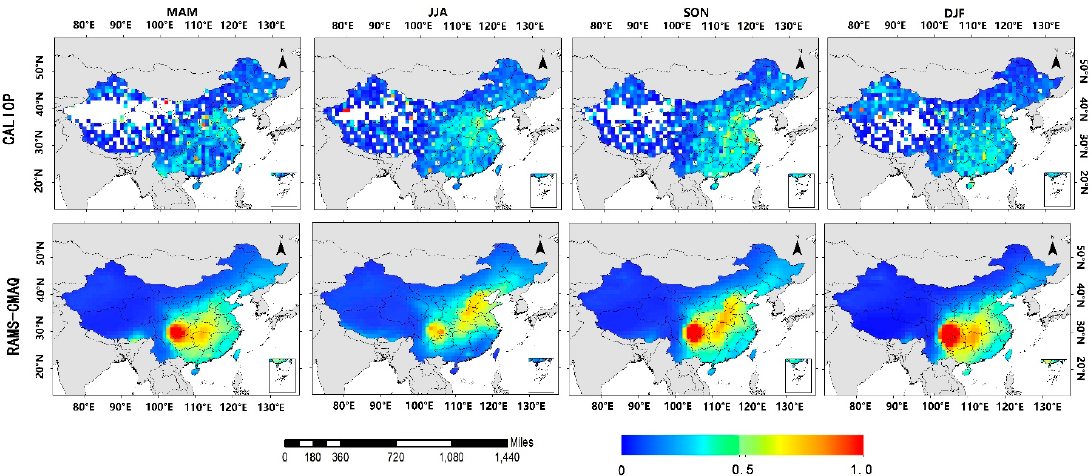
Figure 3. AOD spatial distributions of the CALIOP continental aerosols at 532 nm wavelength and RMAS-CMAQ mixing aerosols including sulfate, nitrate, and ammonium at 550 nm wavelength.